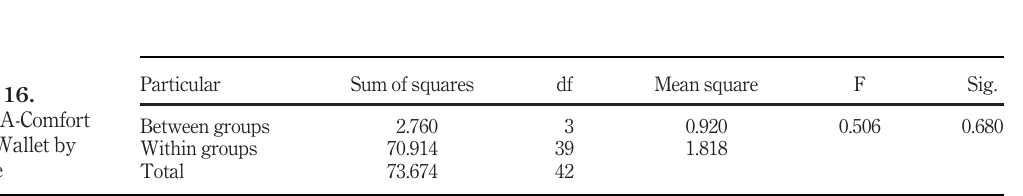
Table 15. Descriptives-Comfort with eWallet by Income